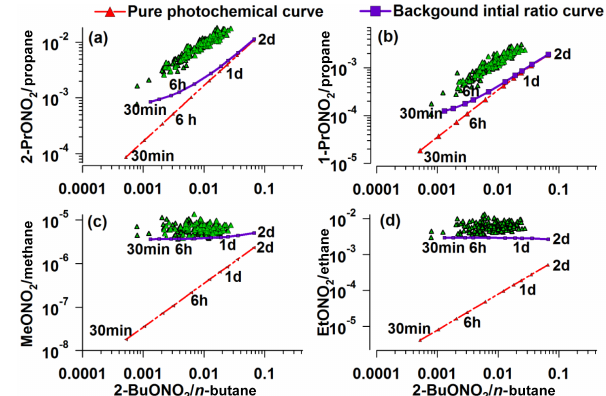
Figure 5. Relationships of C 1 –C 3 RONO 2 / RH with 2- BuONO 2 /n -butane at TMS. The red dashed curves were obtained based on zero initial concentrations of RH and alkyl nitrates (pure photochemical curves, PP), while the blue solid curves were ob- tained based on non-zero initial levels (background initial ratio curves, BIR), with the lowest ratios of RONO 2 / RH from 00:00 to 07:00LT.